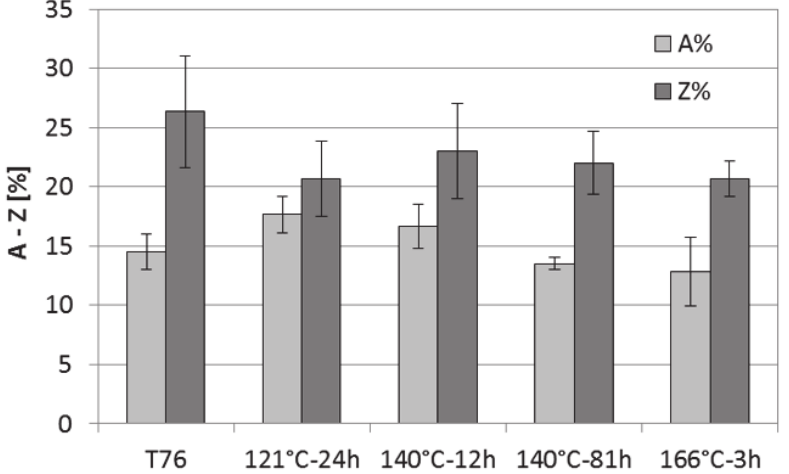
Figure 6: Comparison between the percentage elongations (A%) and the reductions of area